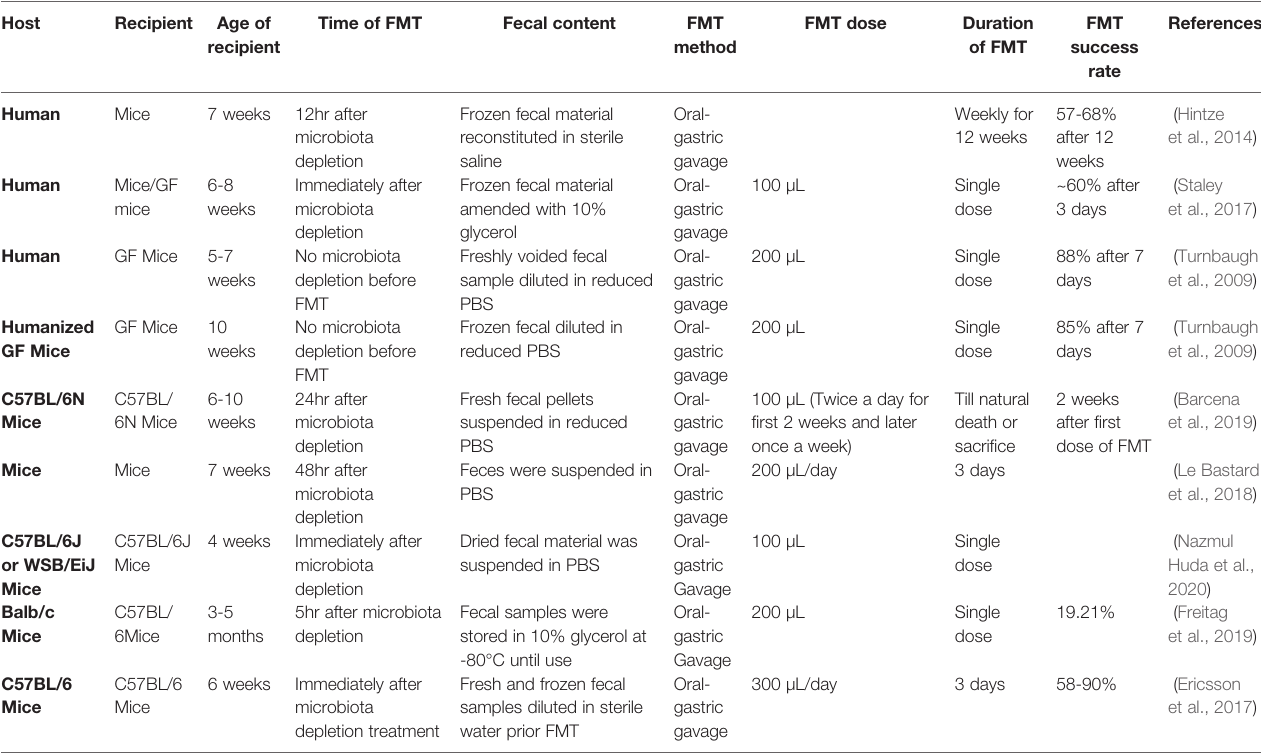
TABLE 2 | FMT dosage details and success rates of